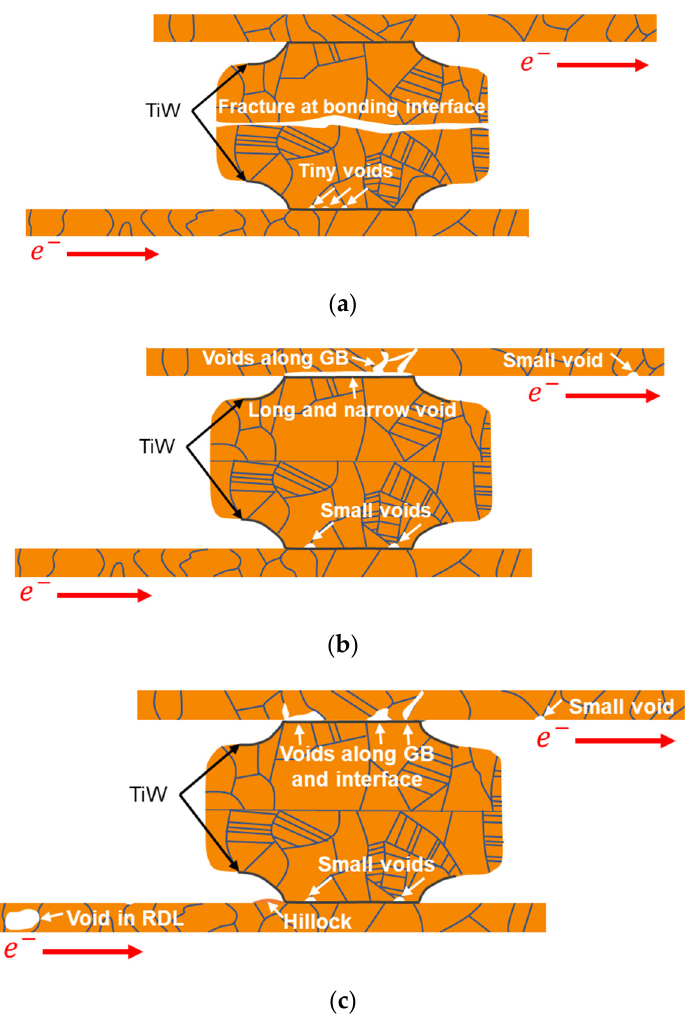
Figure 12. Three kinds of EM failure modes. ( a ) If the bonding strength cannot sustain the tensile stress during the EM test, fracture will occur at the bonding interface. Some tiny voids will form at the PSV opening due to the current crowding effect. This is a kind of early failure. The Cu–Cu bumps of bonding condition 300 ℃/31 MPa/10 s with the bonding strength of about 5 MPa will lead to this failure mode. ( b ) A long and narrow void at the contact area of the PSV opening and RDL, which leads to an open circuit. Some voids grow along grain boundaries. Some small voids form in the Cu–Cu bump at the bottom PSV opening and RDL surface. The Cu–Cu bumps of the bonding condition 300 ℃/90 MPa/30 s with the bonding strength of about 50 MPa have a chance to cause this failure mode. ( c ) Under an excellent bonding condition, some void formation may occur along grain boundaries and the interface in the RDL. Small voids form at the bottom PSV opening of the Cu–Cu bump and RDL surface. In addition, void formation occurs randomly in the RDL far from the Cu–Cu bump. The Cu–Cu bumps of bonding condition 300 ℃/90 MPa/30 s with a bonding strength of approx- imately 50 MPa have an opportunity to bring about this failure